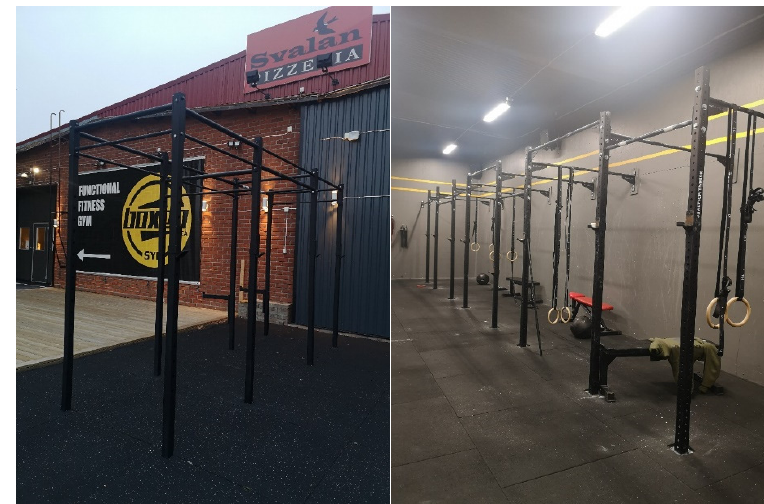
Figure 3. Boxen Umeå Syd (a CrossFit box in Umeå, Sweden).